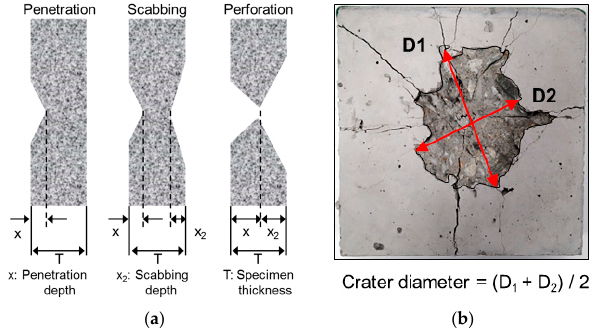
Figure 5. High-velocity impact test device. ( a ) Overall composition of high-velocity impact test device (b) Machine exterior; ( c ) Launch section; ( d ) Velocity measurement system; ( e ) Support and clamp.